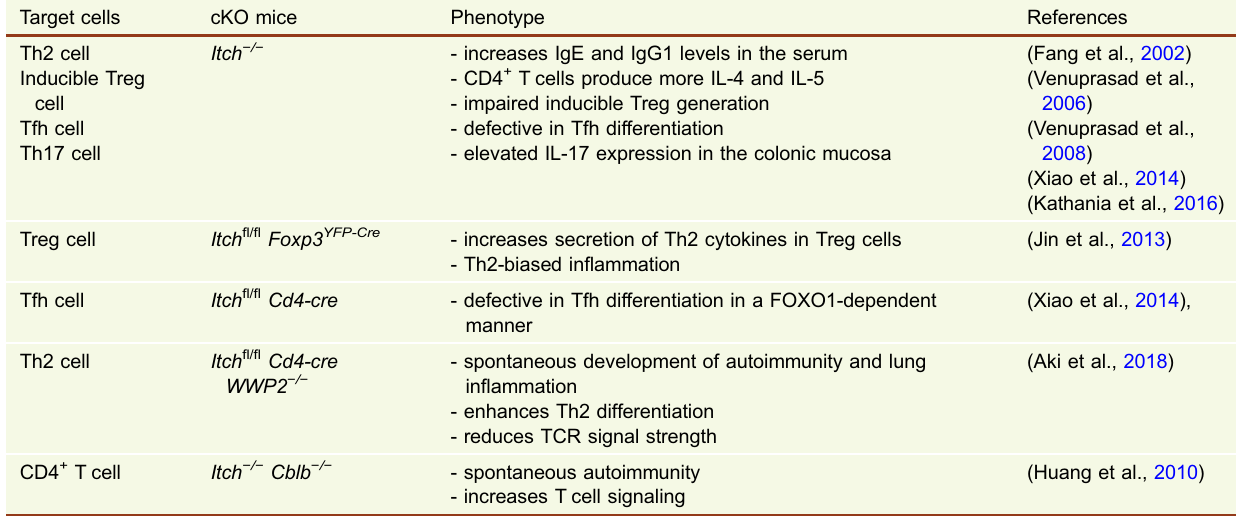
Table 2. The major phenotype of Itch knockout mice. Target